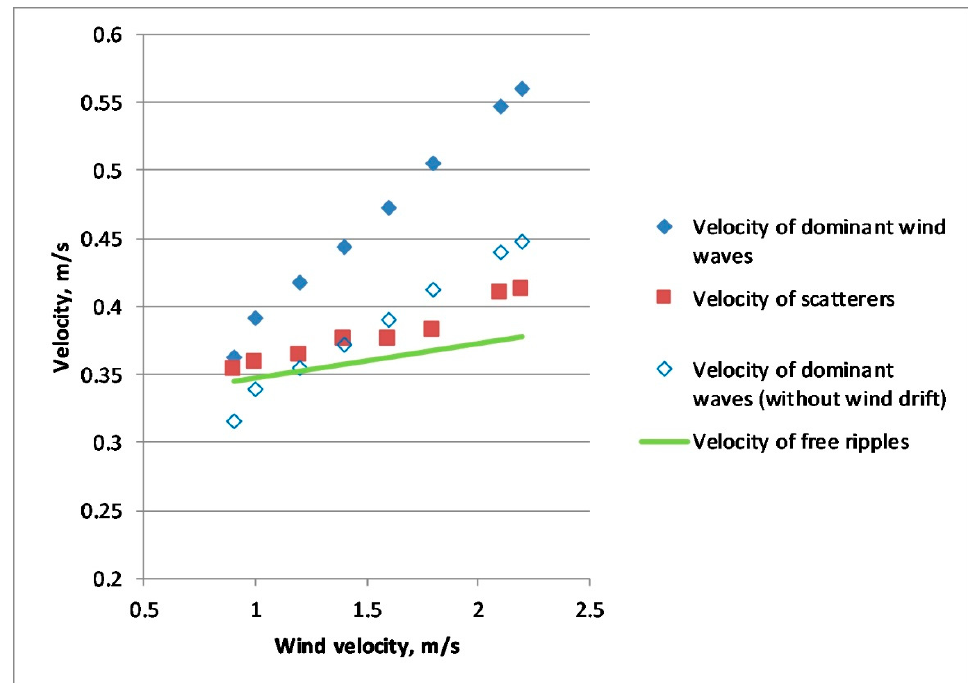
Figure 13. Retrieved velocities of scatterers in the wind wave field (red squares) and velocities of dominant wind waves, taking into account wind drift (solid diamonds) and without wind drift (empty diamonds) as functions of wind velocity. The green curve denotes a theoretical dependence for Bragg, mm-scale waves taking into account wind drift.